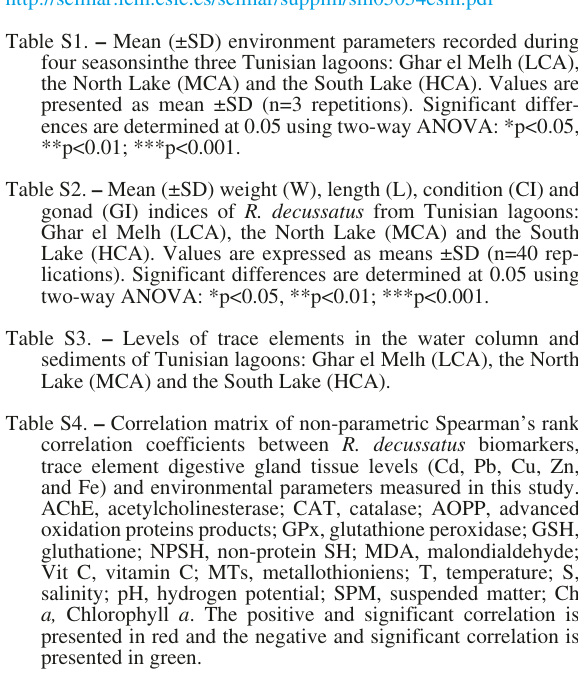
Table S1. – Mean (±SD) environment parameters recorded during four seasonsinthe three Tunisian lagoons: Ghar el Melh (LCA), the North Lake (MCA) and the South Lake (HCA). Values are presented as mean ±SD (n=3 repetitions). Significant differ- ences are determined at 0.05 using two-way ANOVA: *p<0.05, **p<0.01; ***p<0.001. Table S2. – Mean (±SD) weight (W), length (L), condition (CI) and gonad (GI) indices of R. decussatus from Tunisian lagoons: Ghar el Melh (LCA), the North Lake (MCA) and the South Lake (HCA). Values are expressed as means ±SD (n=40 rep- lications). Significant differences are determined at 0.05 using two-way ANOVA: *p<0.05, **p<0.01; ***p<0.001. Table S3. – Levels of trace elements in the water column and sediments of Tunisian lagoons: Ghar el Melh (LCA), the North Lake (MCA) and the South Lake (HCA). Table S4. – Correlation matrix of non-parametric Spearman’s rank correlation coefficients between R. decussatus biomarkers, trace element digestive gland tissue levels (Cd, Pb, Cu, Zn, and Fe) and environmental parameters measured in this study. AChE, acetylcholinesterase; CAT, catalase; AOPP, advanced oxidation proteins products; GPx, glutathione peroxidase; GSH, gluthatione; NPSH, non-protein SH; MDA, malondialdehyde; Vit C, vitamin C; MTs, metallothioniens; T, temperature; S, salinity; pH, hydrogen potential; SPM, suspended matter; Ch a, Chlorophyll a . The positive and significant correlation is presented in red and the negative and significant correlation is presented in